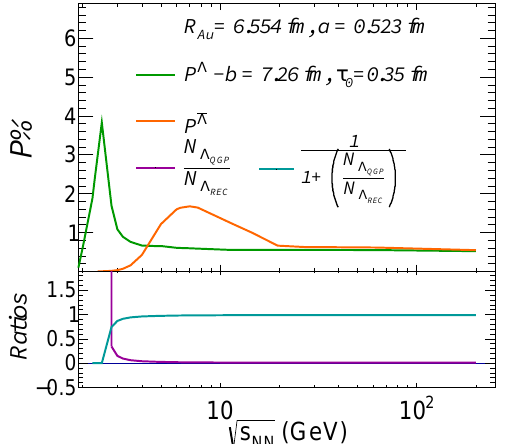
Figure 4. Global polarization P Λ and P Λ as functions of collision energy and fixed values of the model parameters.